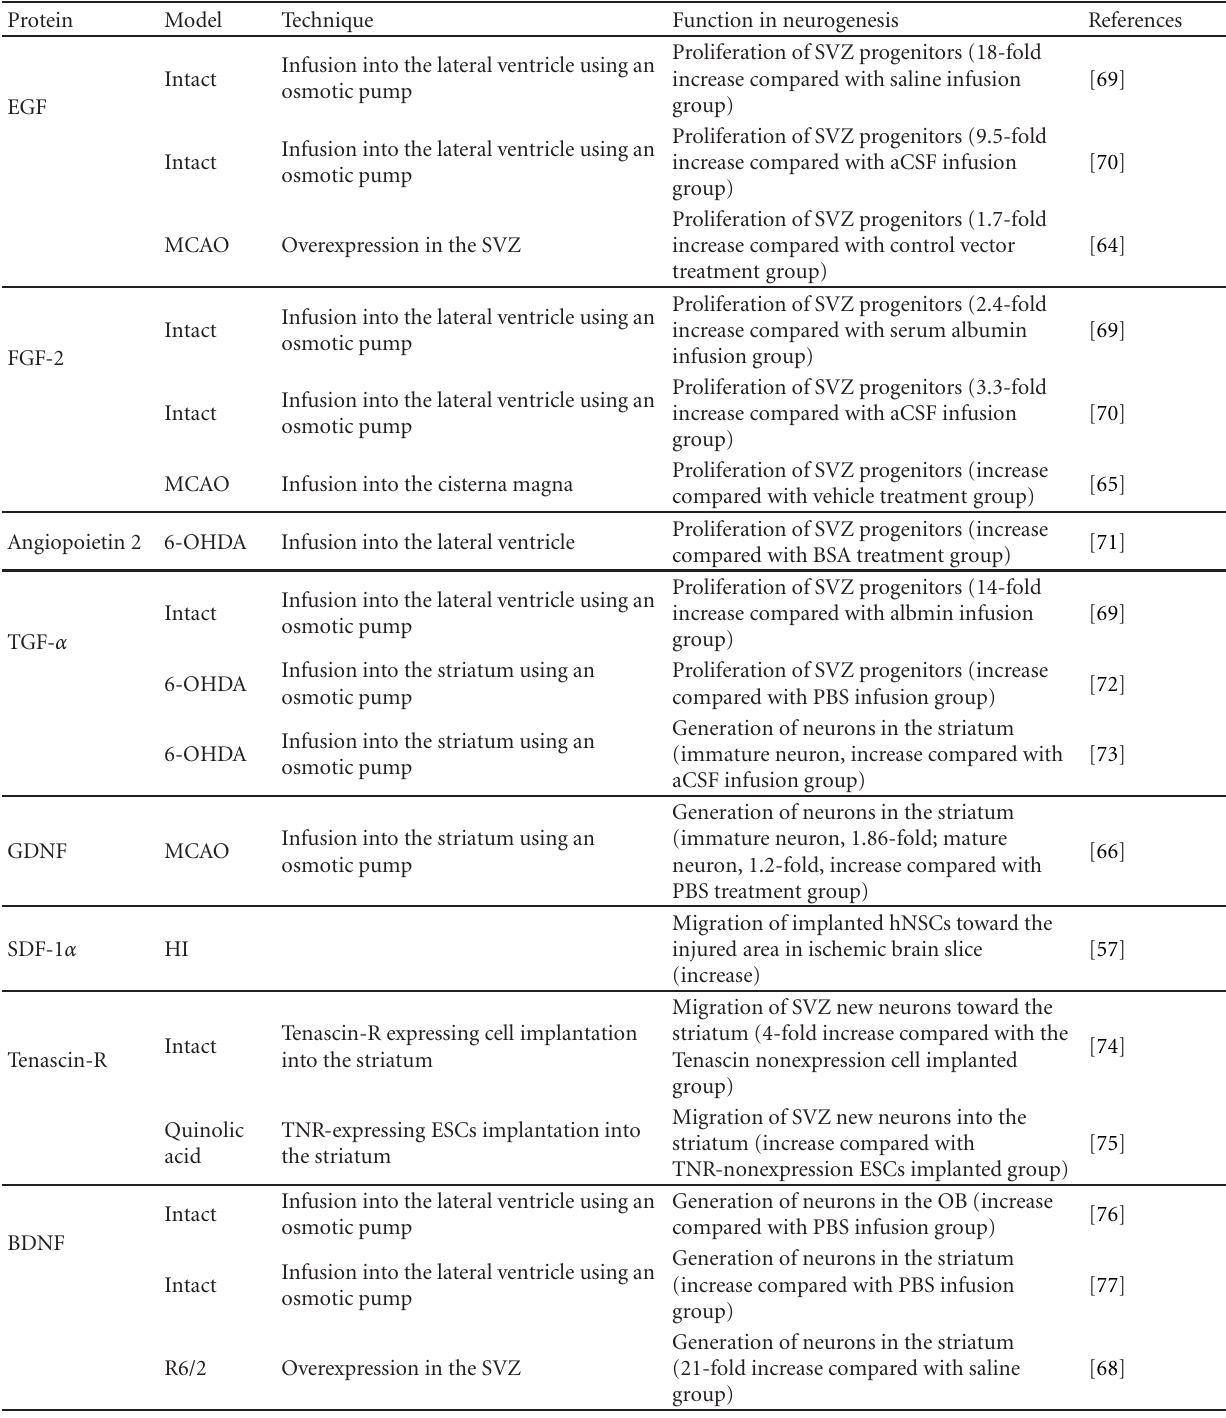
Table 1: Factors promoting the regeneration of neurons in the striatum. This table lists examples of interventions that could increase the proliferation of neural stem/progenitor cells in the SVZ, enhance the migration of new neurons into the striatum, and promote their di ff erentiation/maturation and survival, which could be promising strategies for replacing degenerated neurons with new ones derived from endogenous neural stem cells of the adult SVZ. SVZ, subventricular zone; RMS, rostral migratory stream; OB, olfactory bulb; TH, tyrosine hydroxylase; EGF, epidermal growth factor; FGF-2, fibroblast growth factor 2; TGF- α , transforming growth factor α ; GDNF, glial